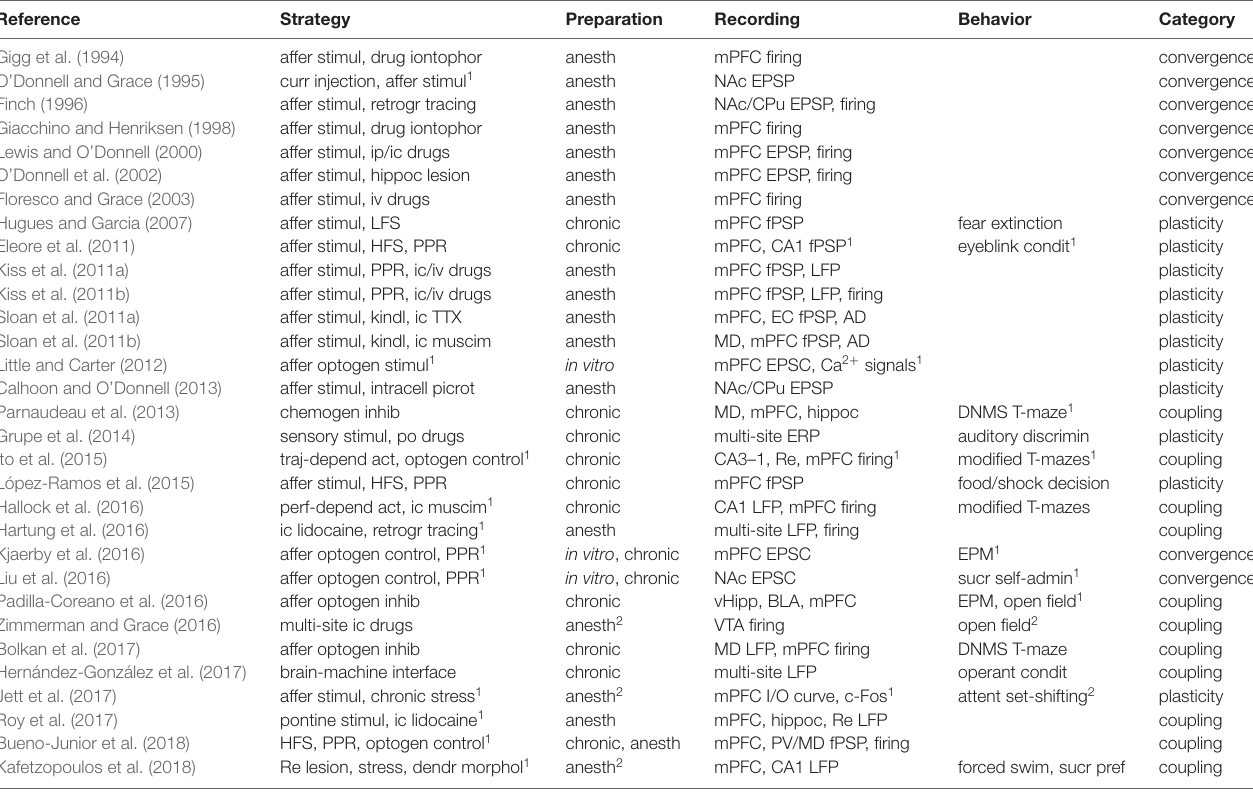
TABLE 1 | Methodological overview of the delimited literature (31